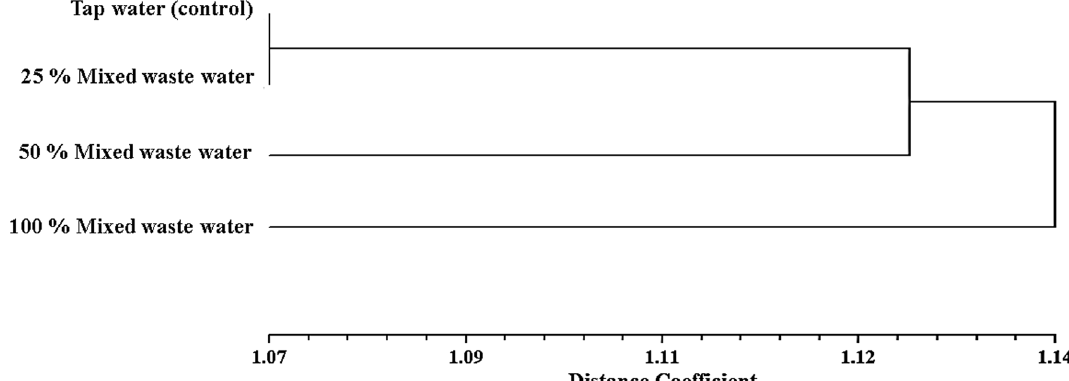
Fig. 8 Dendrogram illustrating differentiation of Allium cepa treated with tap water as control, 25%, 50% and 100% of mixed wastewater at 12th day after germination based on polymorphism in ISSR